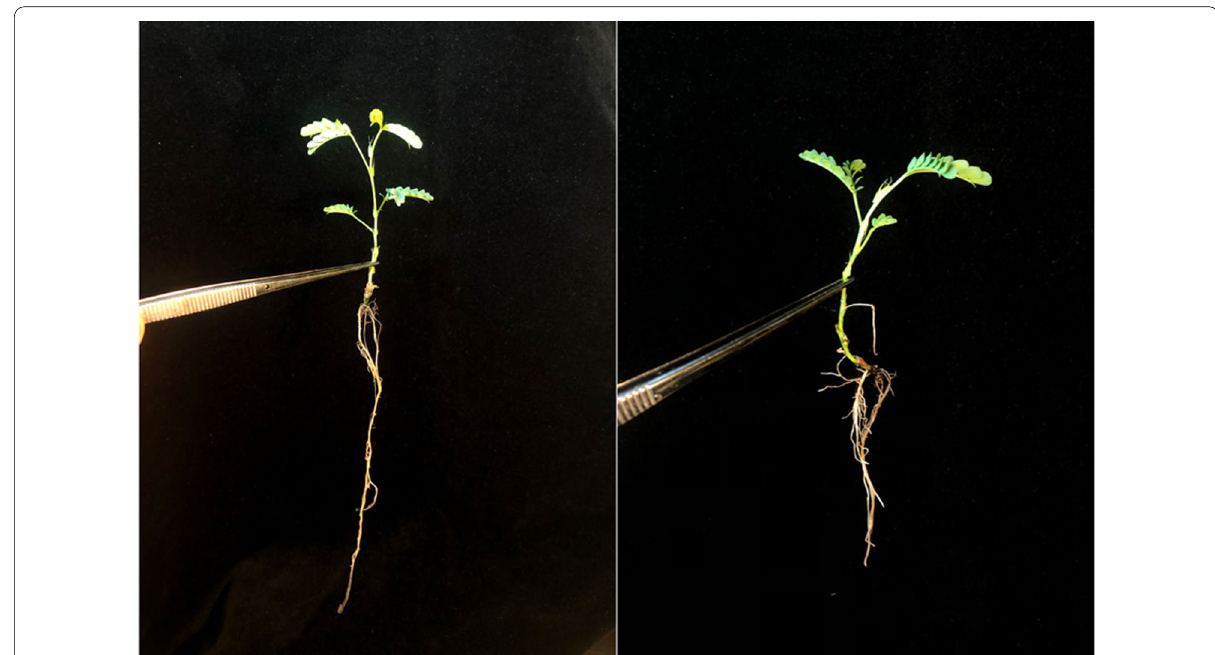
Fig. 2 Se dosed clonal plantlets after being removed from soil after 4–5 weeks and washed prior to ICP‑AES analysis. Well‑developed root with root